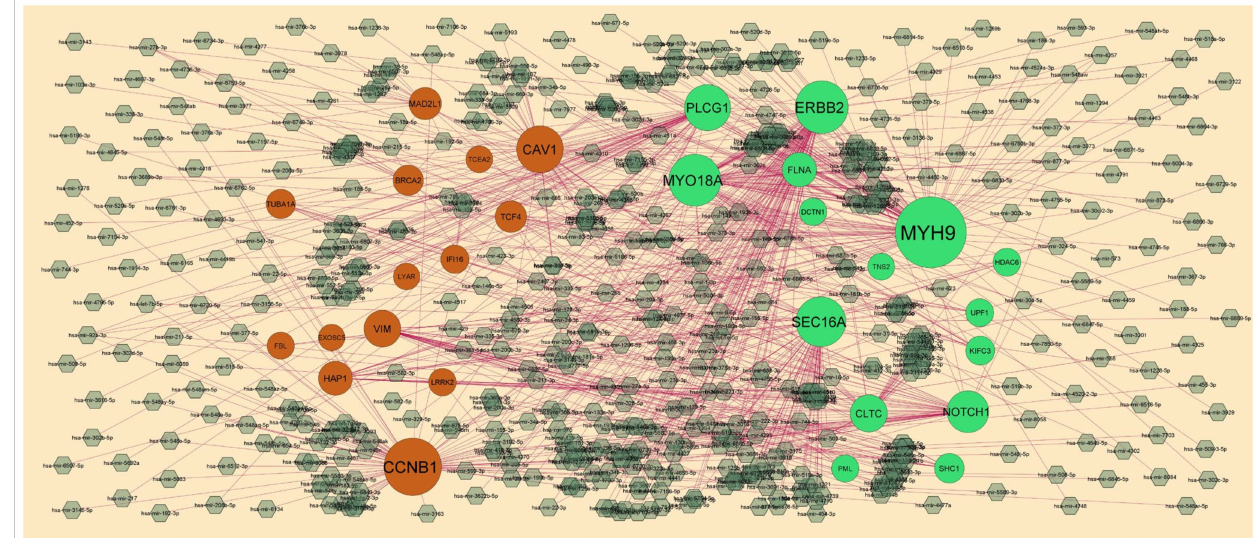
Figure 6. Target gene–miRNA regulatory network between target genes. The black-color diamond nodes represent the key miRNAs; up-regulated genes are marked in green; down-regulated genes are marked in orange.